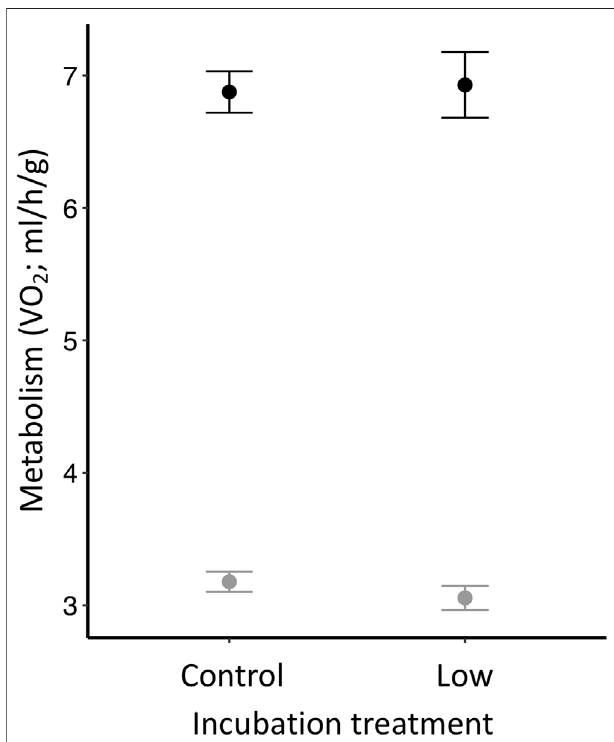
FIGURE 3 | Zebra fi nch metabolic rate (VO 2 ; ml/h/g) measured at two different temperatures (black = TMR: 12 ° C; gray = RMR: 32 ° C). Individuals were measured at Day 30 and had hatched from eggs incubated at two different temperatures (i.e., control or